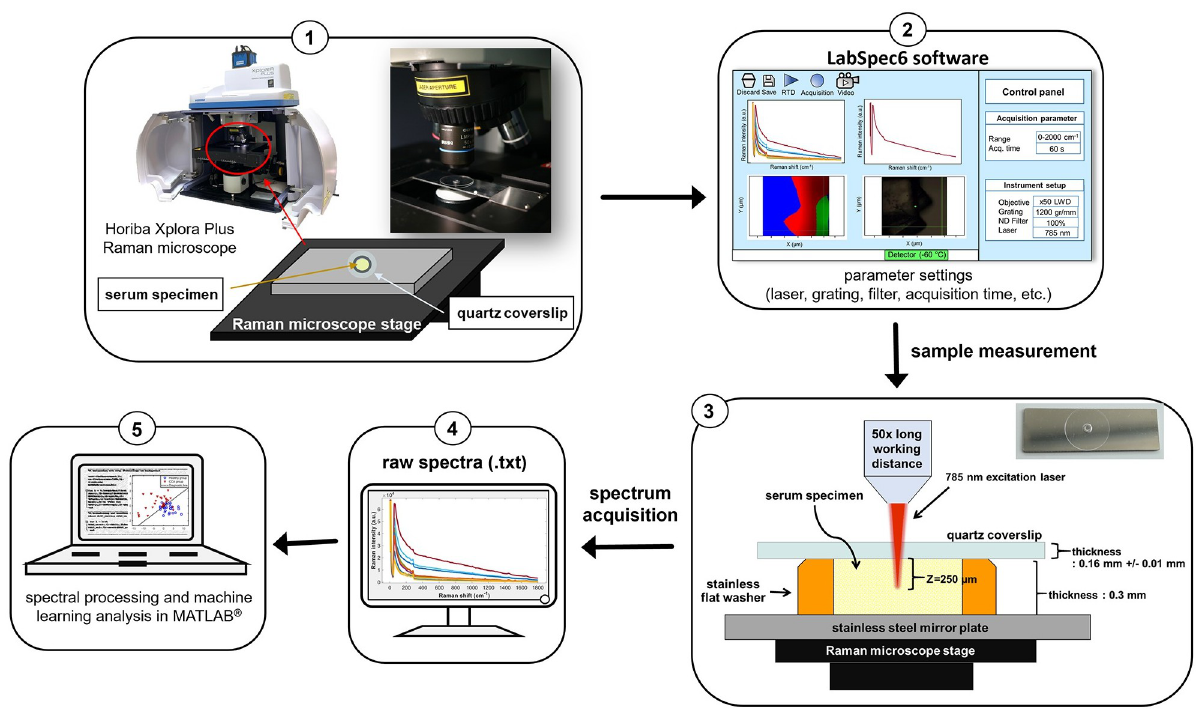
Fig 1. Experimental setup and procedure for Raman measurements of serum specimens of cholangiocarcinoma and healthy groups. The experimental steps consisted of: (1) placing a sample well containing 2.3 μ l serum sample on a Raman microscope stage, (2) setting measurement parameters, (3) measuring serum samples with a laser excitation wavelength of 785 nm, (4) recording raw spectral data in LabSpac6 software, and (5) exporting the collected data to MATLAB for furfure spectral processing and machine learning classification analysis.